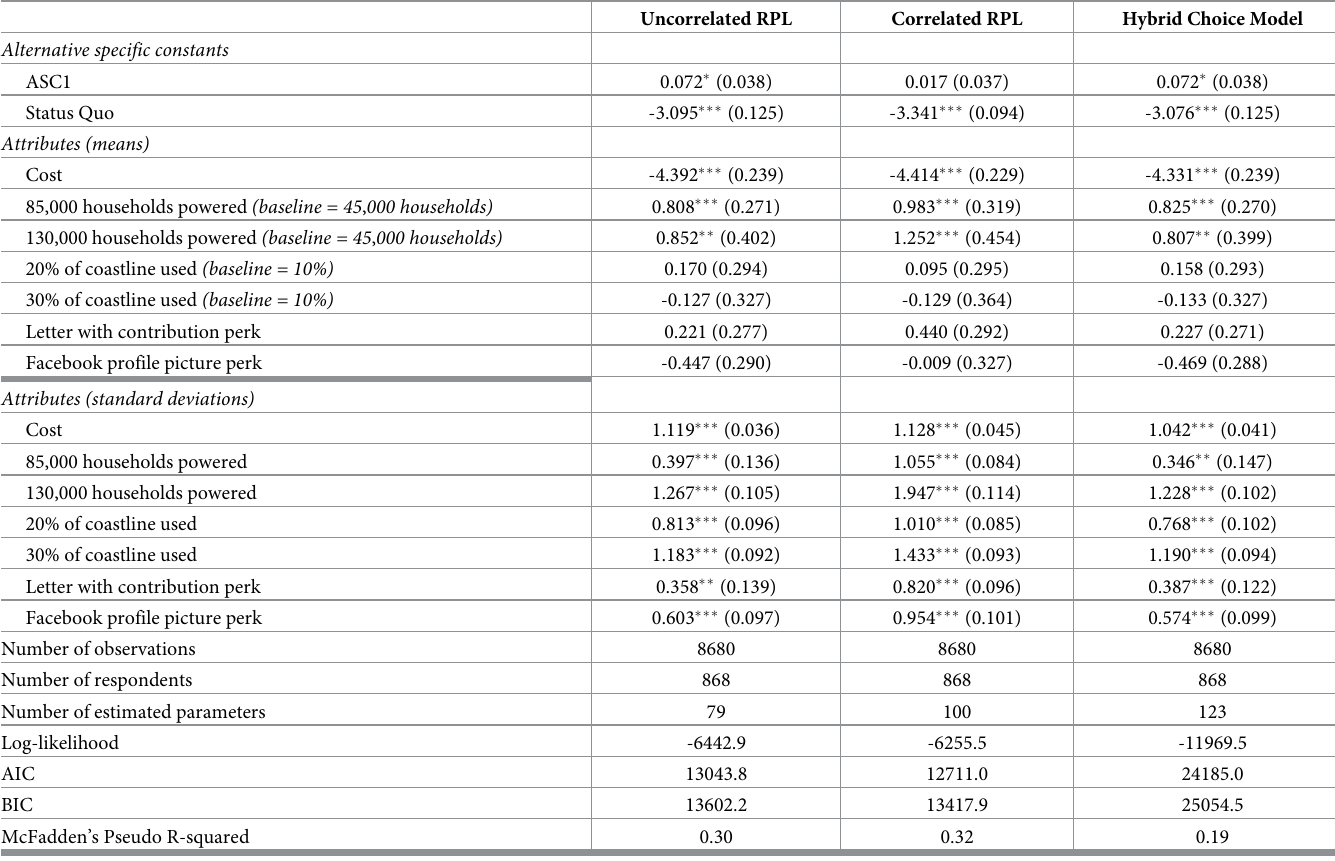
Table 6. Model estimations for